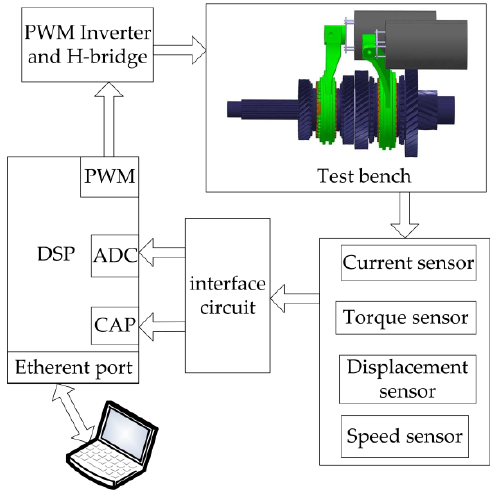
Figure 12. The experimental set up.